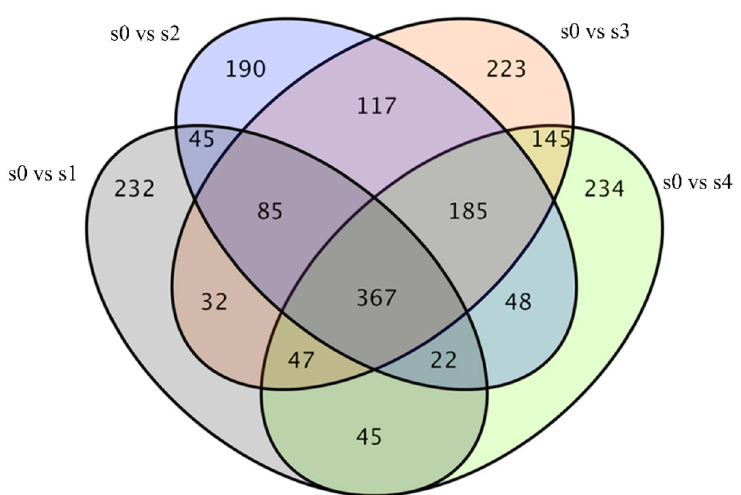
Figure 2. Venn diagram of